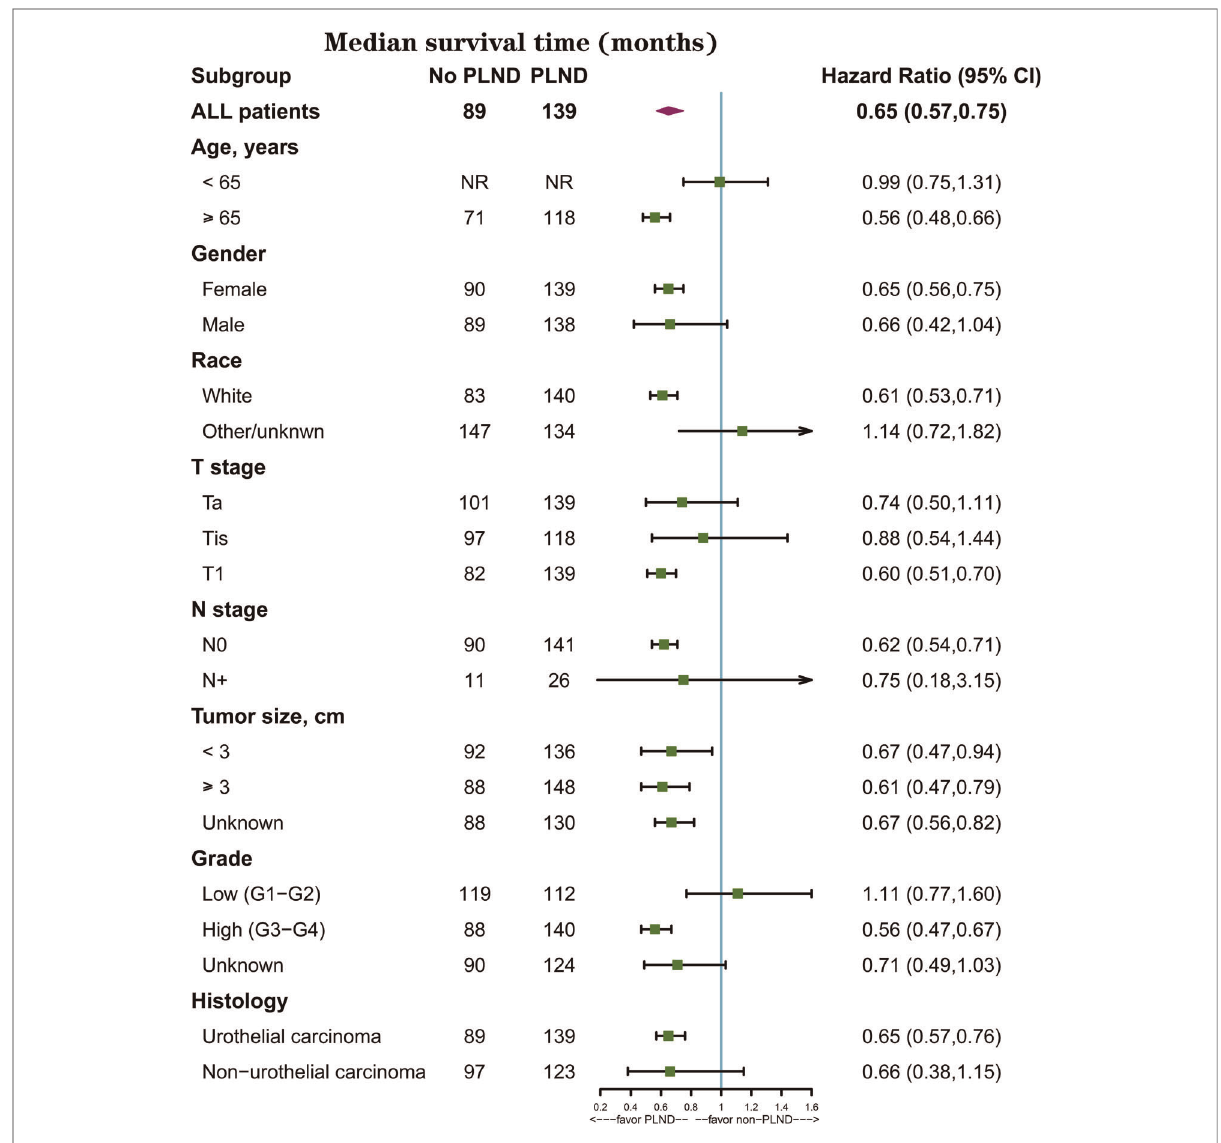
FIGURE 3 Effect of PLND in all prespeci fi ed